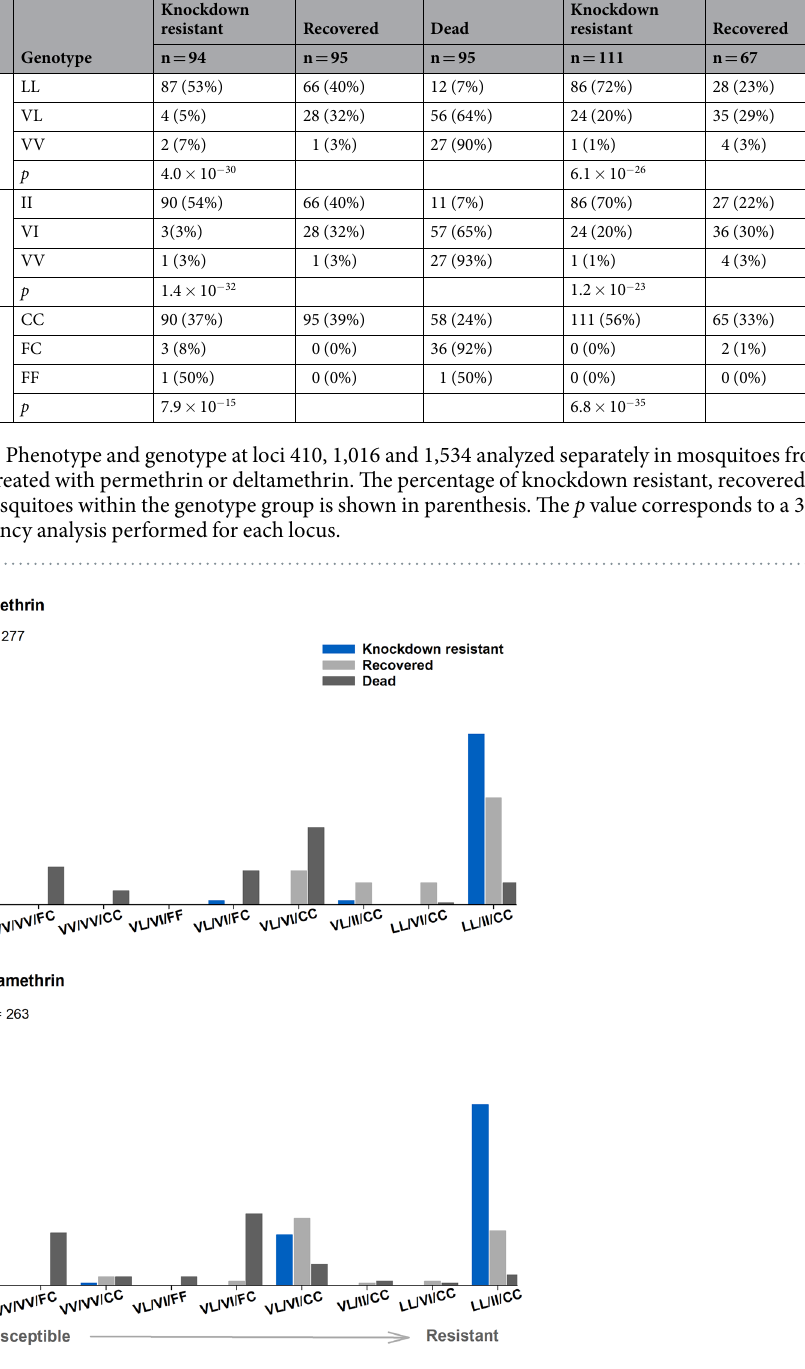
Figure 4. Frequencies of tri-locus genotypes in knockdown resistant, recovered and dead mosquitoes following ( a ) permethrin or ( b ) deltamethrin exposure. The order of the genotypes is shown for locus 410/1,016/1,534 respectively. Resistant allele at loci 410 = L, 1,016 = I and 1,534 = C. The triple susceptible genotype is closer to the y axis whereas the triple resistant genotype is shown on the far right side of the x